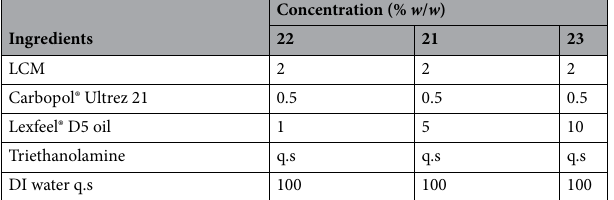
Table 8. Formulations of LLCs using different concentrations of Lexfeel® D5 oil. LCM: Liquid Crystal Cream Maker (sorbitan stearate and sucrose cocoate); Carbopol® Ultrez 21: acrylates/C10–30 alkyl acrylate cross- polymer; Lexfeel® D5 oil: neopentyl glycol diheptanoate and isododecane. Formulations 21–23 used Lexfeel® D5 oil at concentrations ranging from 1 to 10% w / w.